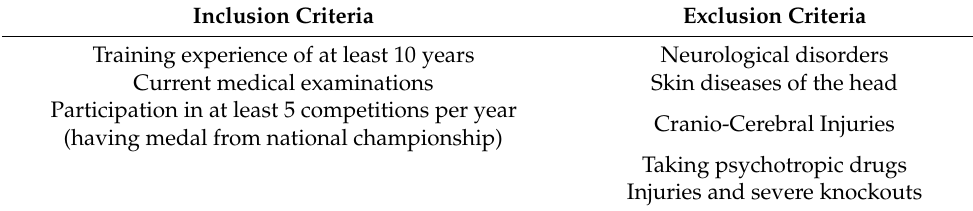
Table 1. Inclusion and exclusion